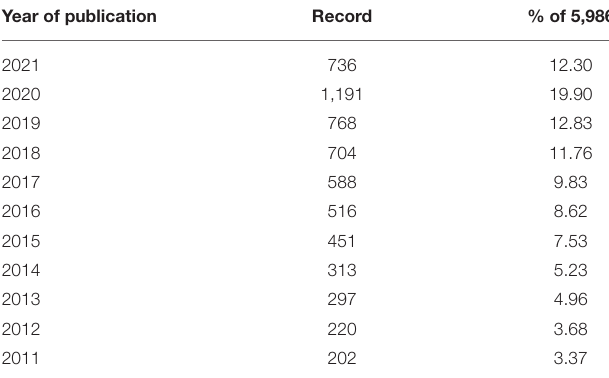
of COVID-19 in late 2019. ECMO has obtained worldwide attention as an effective treatment, and extensive studies have been conducted on the indications and efficacy